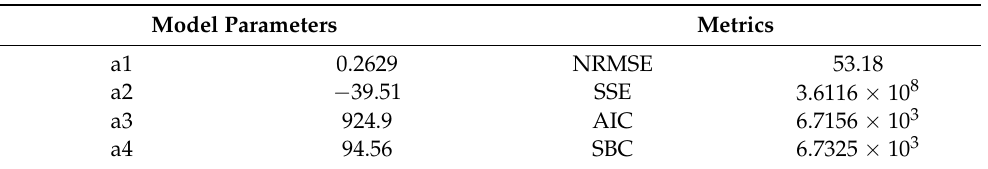
Table 8. Overview of the parameters of the created custom model and performance metrics of the DMSP-40 muscle validation